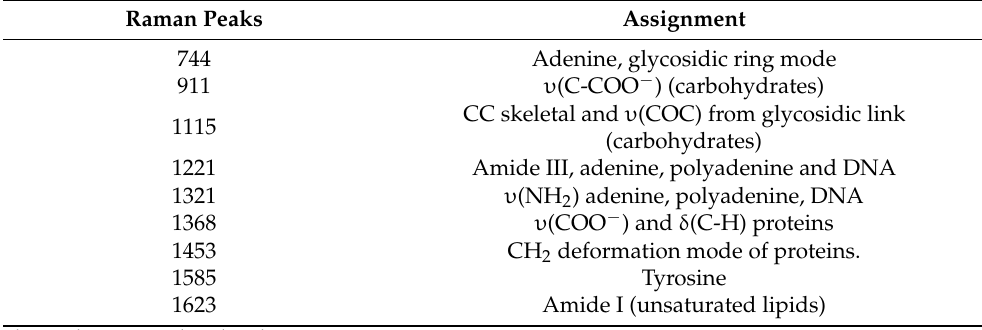
Table 1. Raman peaks of the surface-enhanced Raman scattering (SERS) spectrum of Escherichia coli on the gold nanoisland film (AuNIF).